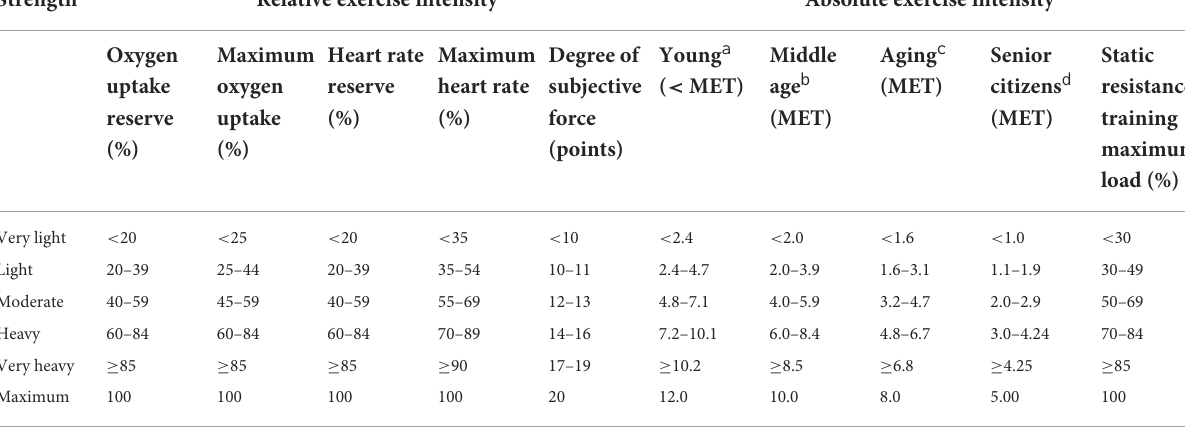
TABLE 1 American college of sports medicine exercise intensity ratings for healthy adults. Strength Relative exercise intensity Absolute exercise